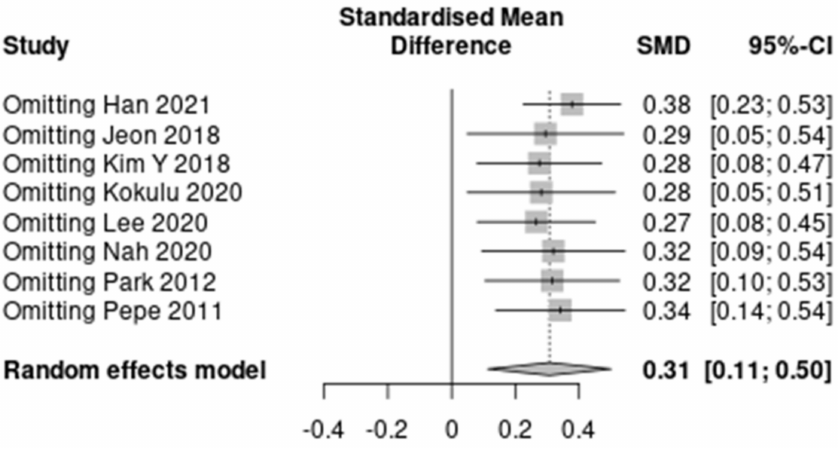
Figure 3. A summary of the sensitivity analysis